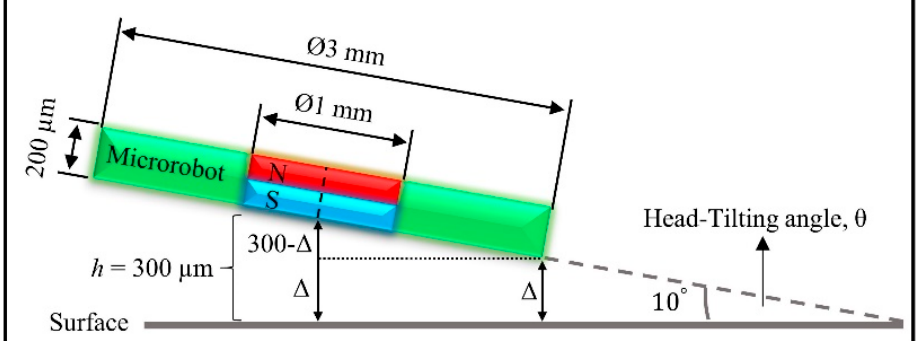
Figure 3. Illustration of levitation height determination in relation to the microrobot-head-tilting angle.